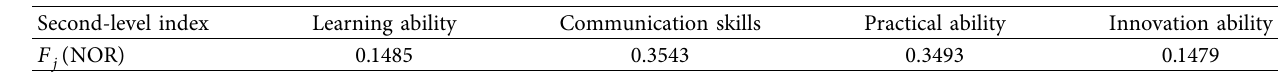
Table 14: F j (NOR) of ability and quality.